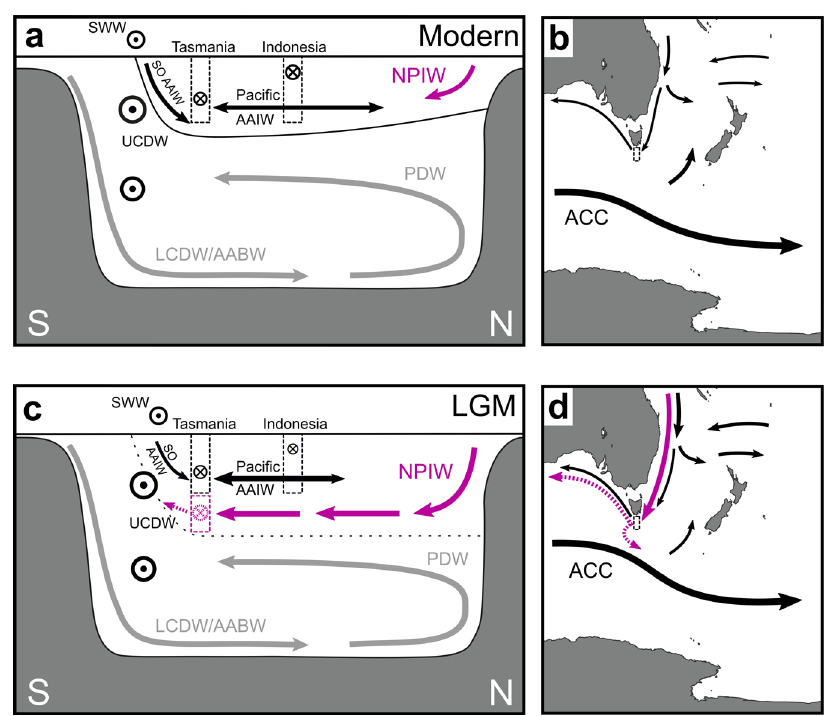
Fig. 5 Schematic of inferred circulation changes between the modern-day and the Last Glacial Maximum (LGM). Cross-sections show the Paci fi c Ocean circulation for a the modern-day and c the LGM. Maps focus on the intermediate-depth circulation in the study area near Tasmania for b the present-day (see also Fig. 1a) and d the LGM. Base maps in b , d produced with ODV software 97 . Water mass pathways are indicated by arrows: Antarctic Intermediate Water (AAIW, black) and North Paci fi c Intermediate Water (NPIW, purple). SO: Southern Ocean. Note that the eastward fl ow of the Antarctic Circumpolar Current (ACC) (circled dots in a and c ) comprises also Upper Circumpolar Deep Water (UCDW) and Lower Circumpolar Deep Water (LCDW) (see also Fig. 1b for more details). Note also that the two possible pathways of glacial Tasman out fl ow waters are indicated by stippled lines in c , d and that the purple arrows in c , d do not represent pure NPIW, since it is in fl uenced by the admixture of other ambient water masses during its southwards transport (see main text). Gray arrows in a , c indicate the deep overturning, where upwelling of LCDW and Antarctic Bottom Water (AABW) feeds into the southward return fl ow of Paci fi c Deep Water (PDW). Flow strengths are schematically represented by the thickness of arrows (meridional fl ows) or the size of the circled dots/crosses (zonal fl ows). The solid black line in a represents the intermediate water layer ventilated primarily by AAIW and NPIW in the modern Paci fi c Ocean, while the stippled black line in c indicates the deepened LGM analogue. Dashed boxes indicate the locations and approximate depth extents of Paci fi c out fl ow along the Tasman margin and through the Indonesian Seas. The position of the Southern Westerly Winds (SWW) is also shown with circled